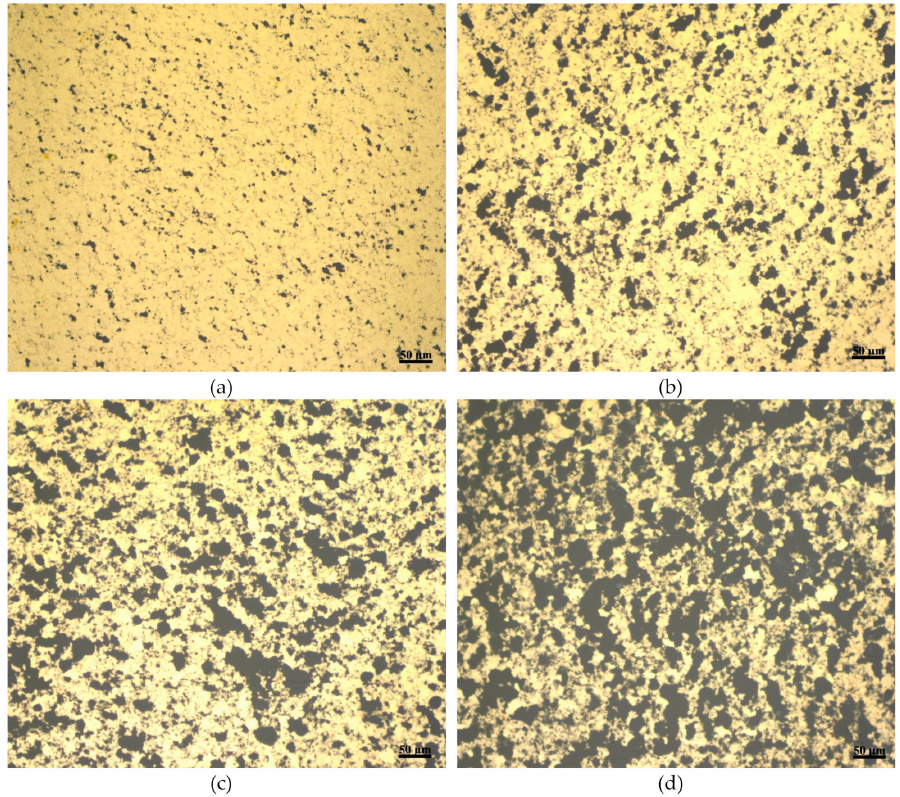
Figure 7. Microscopic images for porous gold film fabricated with di ff erent etching times: ( a ) 15 s ( b ) 30 s ( c ) 45 s, ( d ) 60 s, where the thickness of the gold film for all wafers is ~800 nm and the concentration of the GO dispersion is 4 mg /